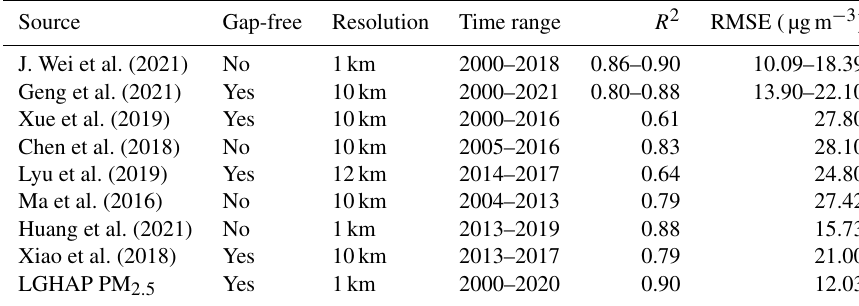
Figure 4. Spatial patterns of the reconstructed AOD under different baseline AOD coverage ratios. In each panel, the upper part presents the original AOD distribution from Terra MODIS and the gap-filled imagery is shown below. The zoomed-in views of the outlined regions are shown on the right. Dates are given in the format year/month/day. Table 3. Comparison of the data quality of PM 2 . 5 from LGHAP with other related